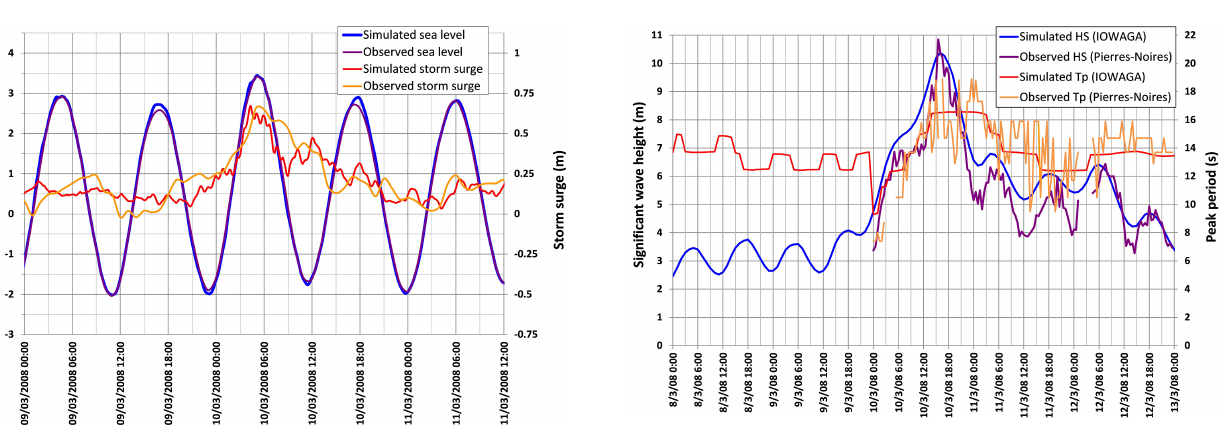
Figure 4. Validation of the total sea level (tide and storm surge) and of the storm surge simulated with MARS in Port-Tudy (observation from http://refmar.shom.fr).